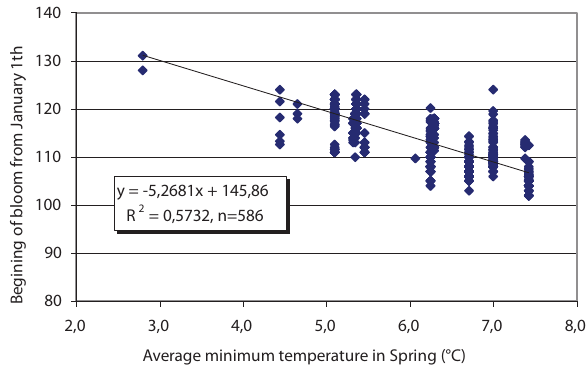
Figure 5. Relationship between the begining of bloom and minimum temperature in Spring time in pear gene bank (Újfehértó,